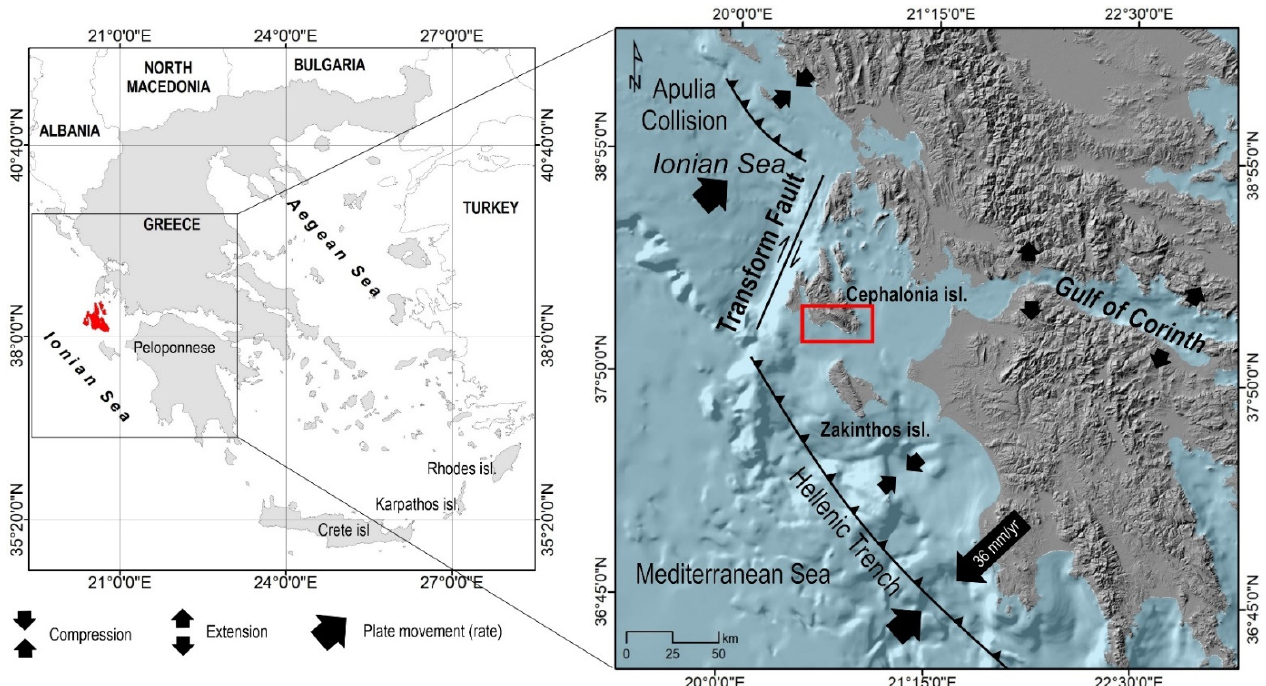
Figure 1. Location of the study area and the general tectonic setting in the Ionian Sea. The study area is indicated with the red rectangular. Note the transform fault (Cephalonia Fault Zone), a major dextral strike slip fault, located offshore, west of the island.